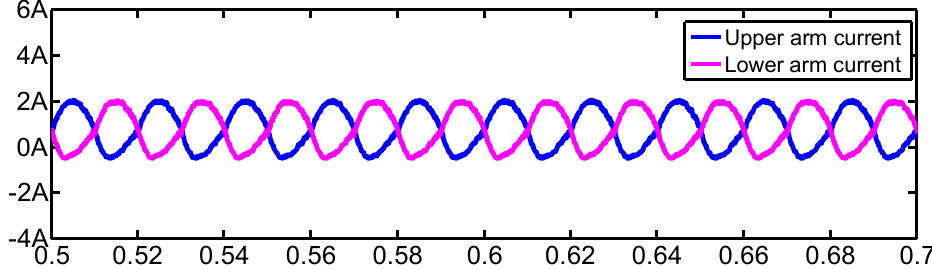
Figure 23 . Arm currents of the proposed hybrid MMC when λ = 0.5. Figure 23. Arm currents of the proposed hybrid MMC when λ =